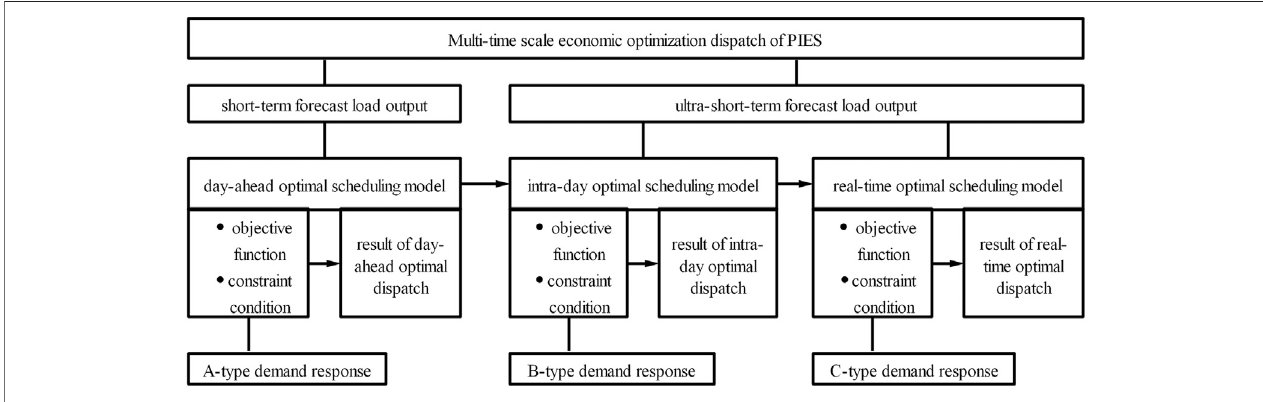
FIGURE 2 | Optimal dispatching framework of